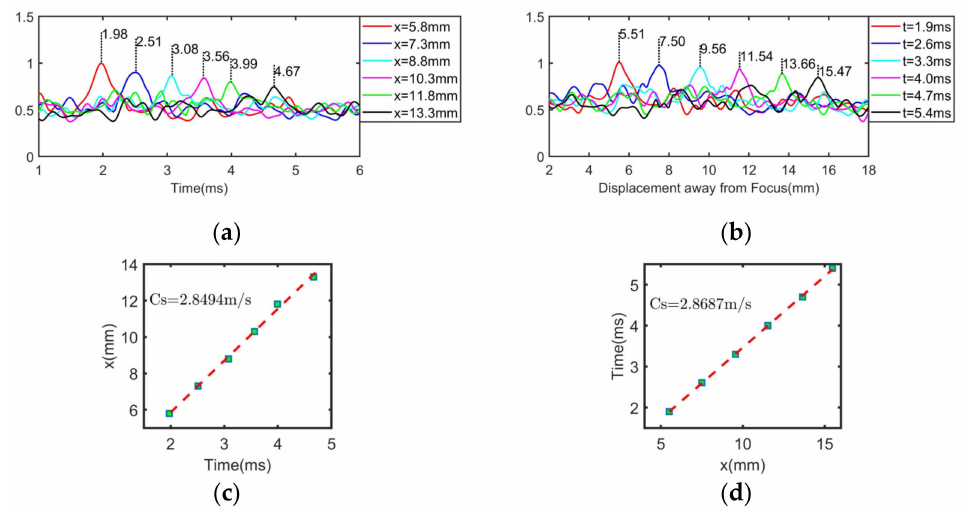
Figure 4. Experimental result of shear wave velocity estimation with the time-to-peak and the lateral peak method. ( a ) Velocity estimation using time-to-peak method. ( b ) Velocity estimation using lateral peak method. ( c ) Linear regression results of time-to-peak method. ( d ) Linear regression results of lateral peak method. Subfigures ( a , b ) are normalized.